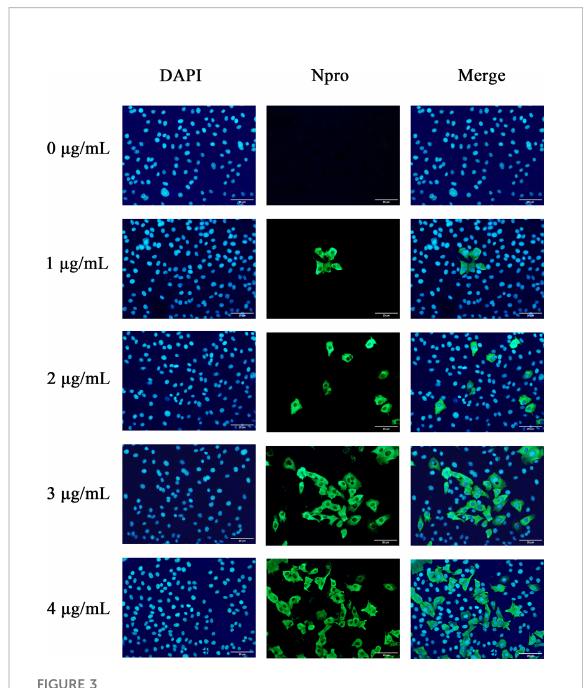
FIGURE 3 Changes in ST cells infected with PDCoV under different trypsin concentrations (400×). DAPI-stained nuclei are blue after UV light excitation and green after blue light excitation after primary and secondary antibodies binding to viral